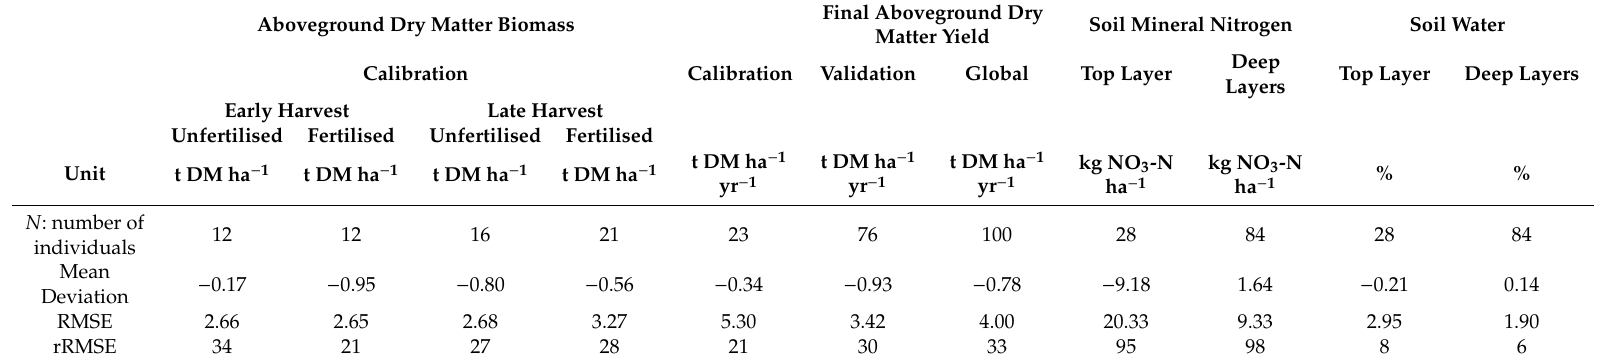
Table 3. Goodness of fit statistics for the simulation of the switchgrass crop.